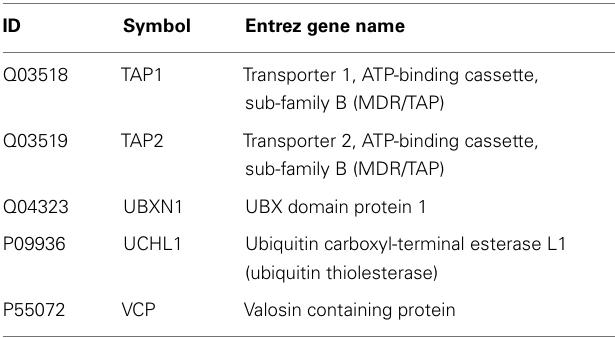
Table 2 | ER/ER-associated proteins identified in a previous proteomic study of human CRCL